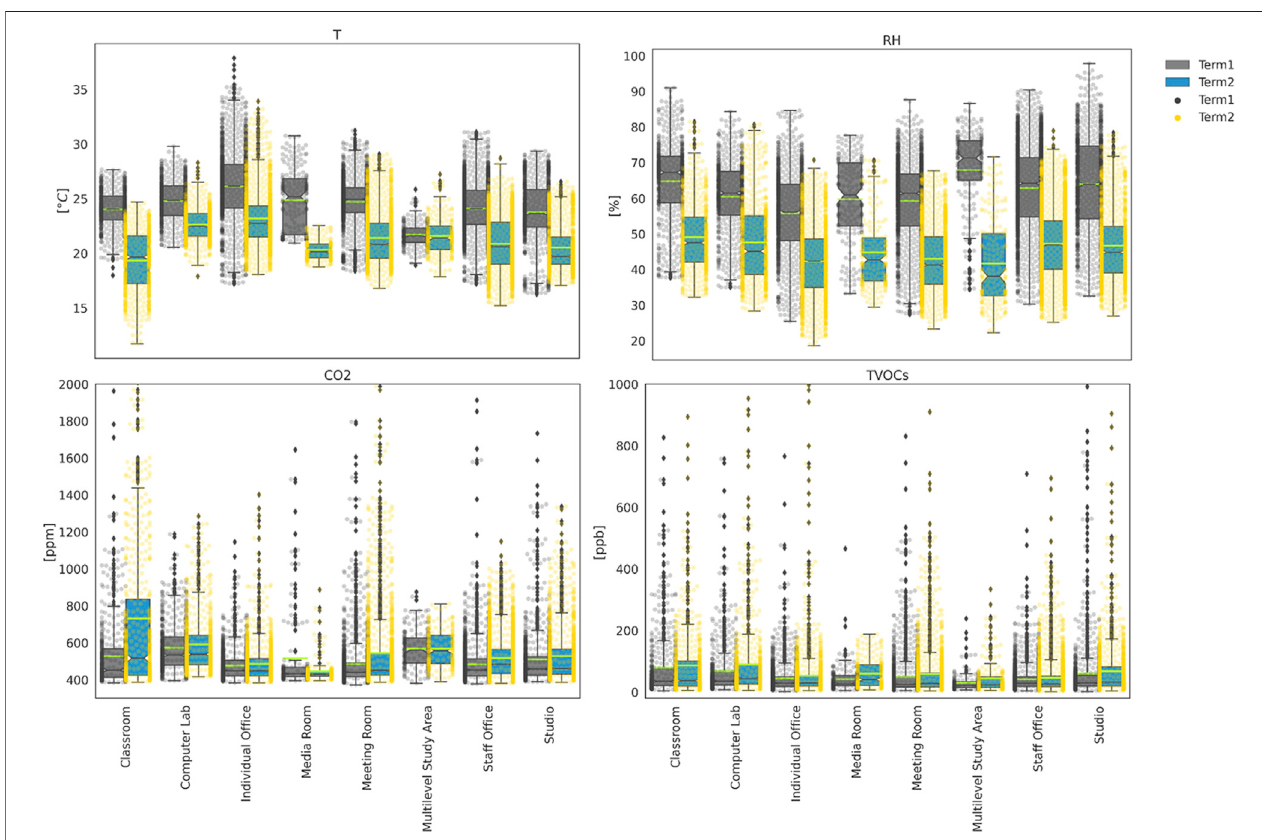
FIGURE5 | IEQ behaviour across different room types: comparison between warm and coldstandard occupancy periods. The y -axis limits are adjusted forbetter visualization. The swarmplots show all mean observations, on hourly scale, and complement the representation of the underlying distribution.